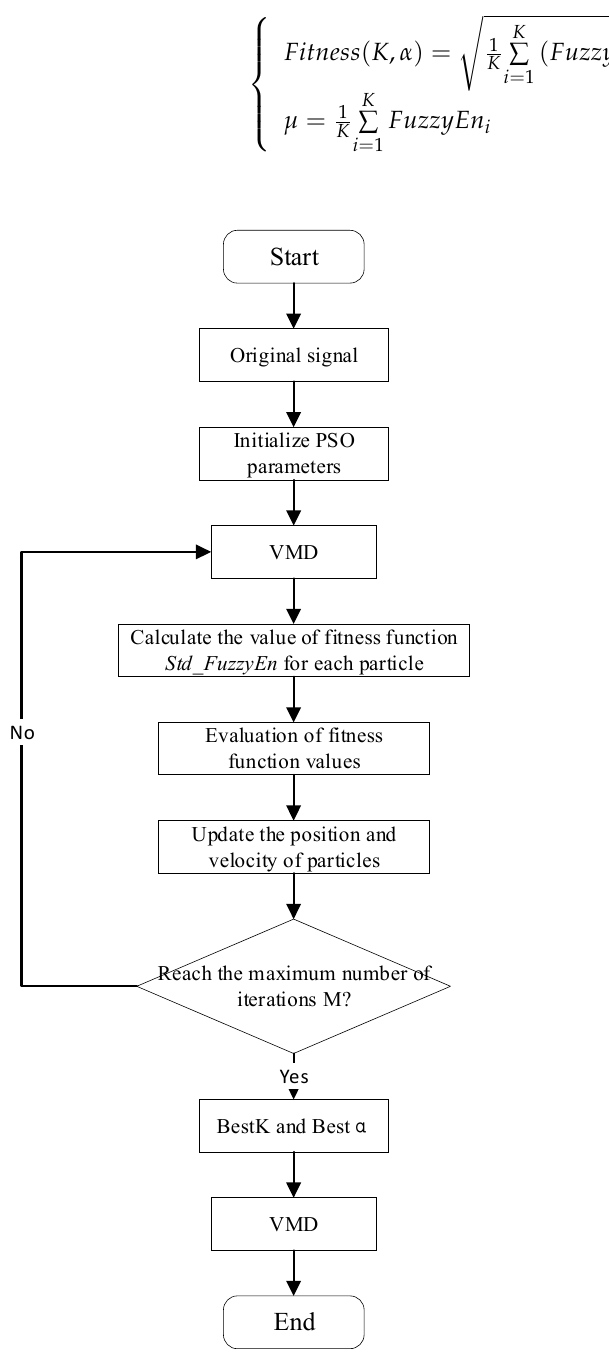
Figure 6. The flow chart of PSO–VMD algorithm.